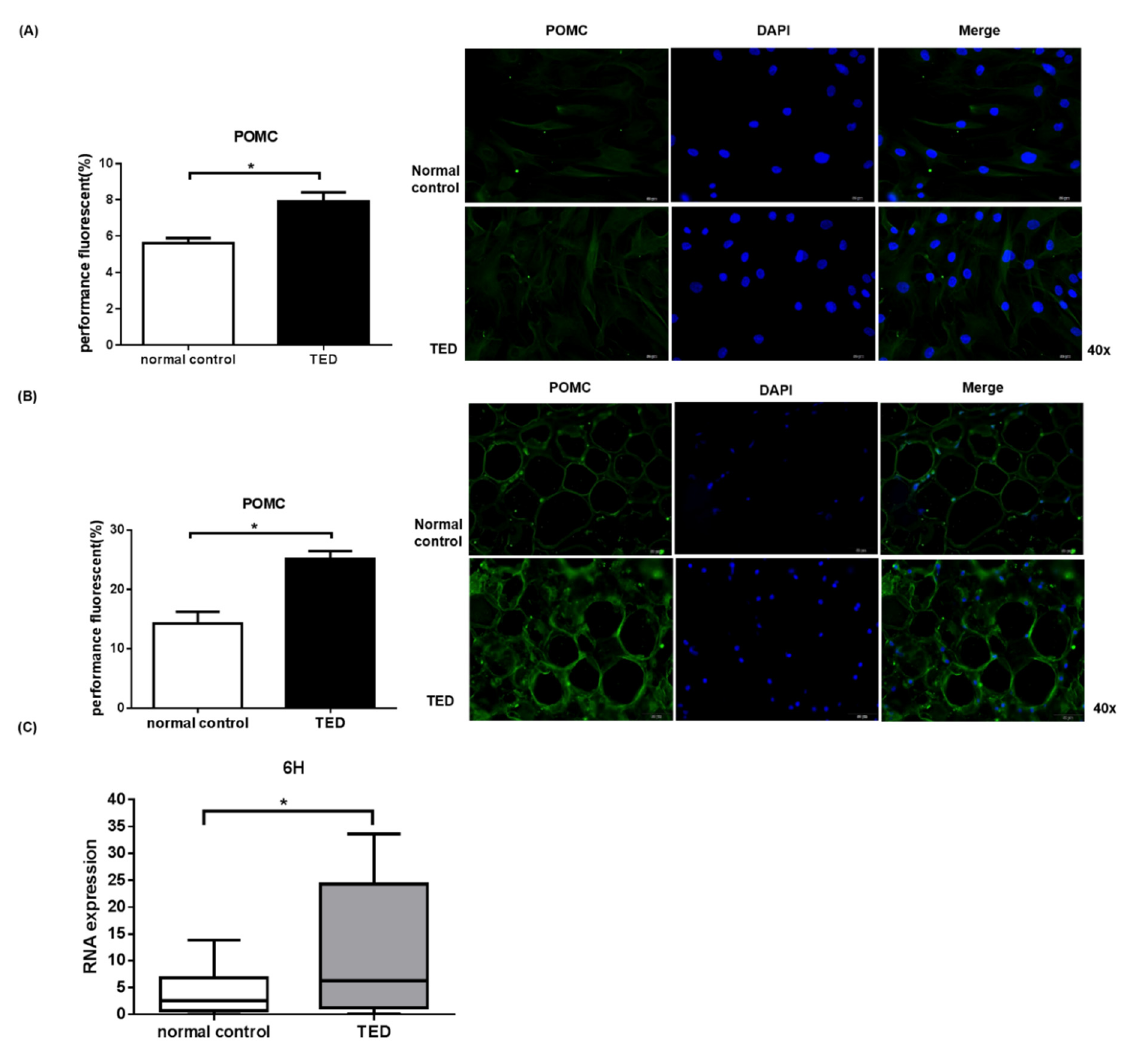
Figure 5. The expression of POMC in orbit fibroblasts and orbit fat tissue from TED and control patients.Immunofluorescence staining assay was performed to examine the expression of POMC levels in primary cultured orbital fibroblasts ( A ) and in orbital fat tissue ( B ). It was found that the expression of POMC in TED was increased compared to the normal control. qPCR assay was performed to examine the POMC mRNA level in orbital fibroblasts. The average SEM multiples of POMC gene levels in TED were higher compared to normal control ( C ). * p < 0.05 compared to normal control.